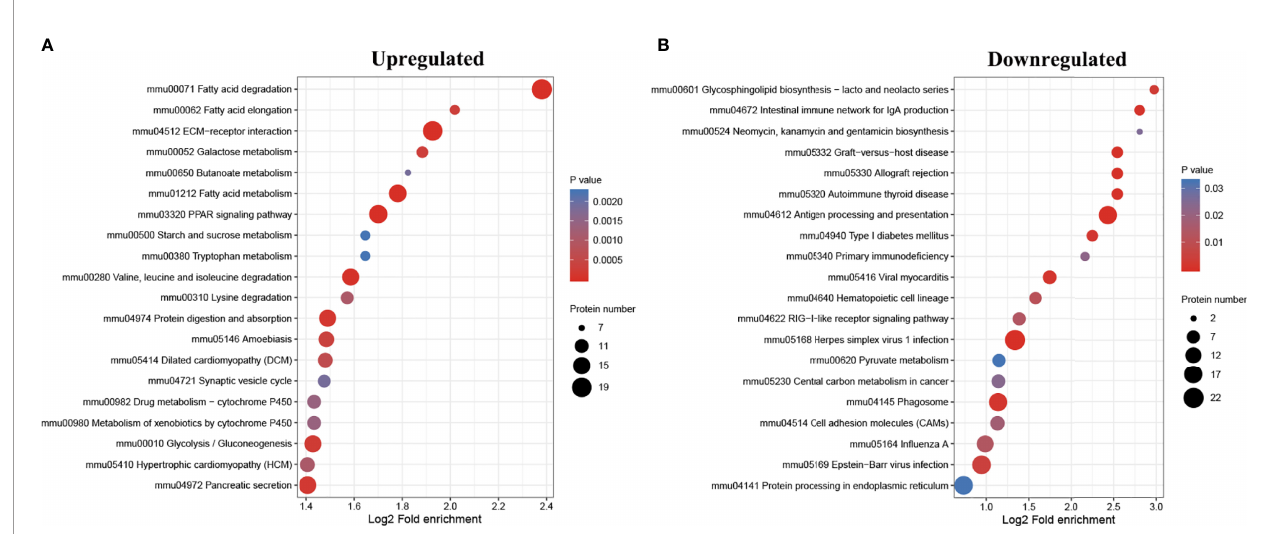
FIGURE 4 | Kyoto Encyclopedia of Genes and Genomes (KEGG) pathway enrichment analysis of the differentially expressed proteins (DEPs). Bubble diagrams displaying the top 20 KEGG pathways for which upregulated (A) and downregulated (B) DEPs were signi fi cantly enriched, respectively. The y-axis shows the IDs and the names of the enriched pathways, and the x-axis shows the converted log2 fold enrichment. The size of the bubbles indicates the number of DEPs in each